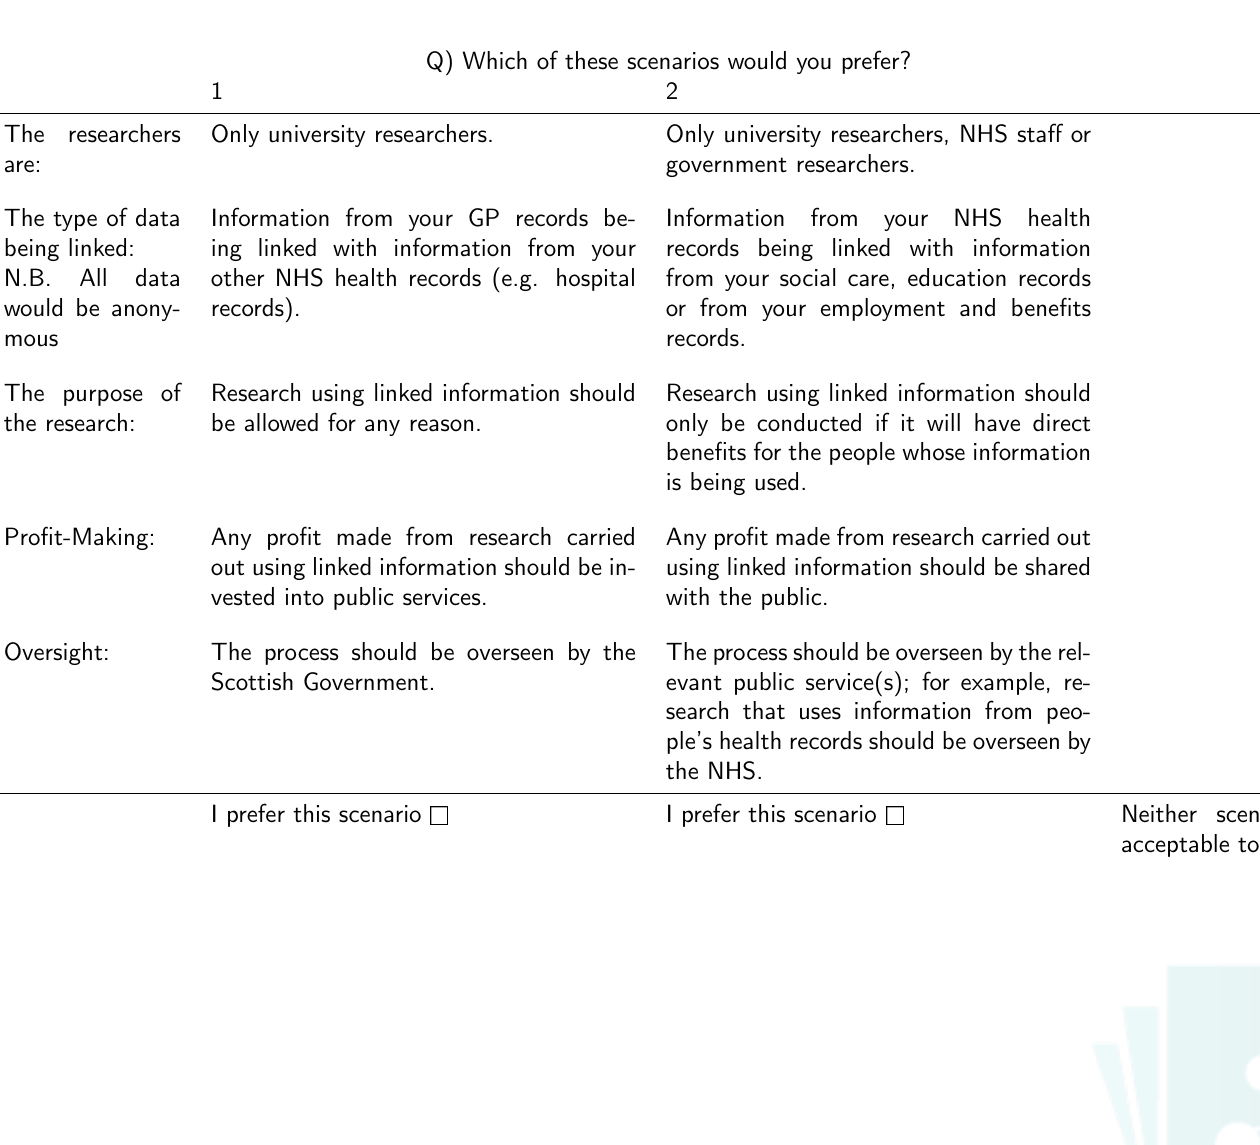
Table 2: Example of scenario